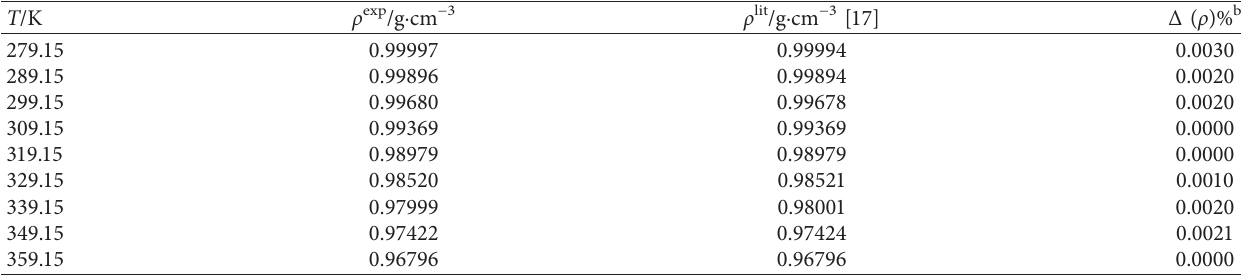
Table 1: Comparison between the experimental ( ρ exp ) and the literature values ( ρ lit ) for pure water at 101.325kPa a . T /K ρ exp /g · cm − 3 ρ lit /g · cm − 3 [17] Δ ( ρ )% b